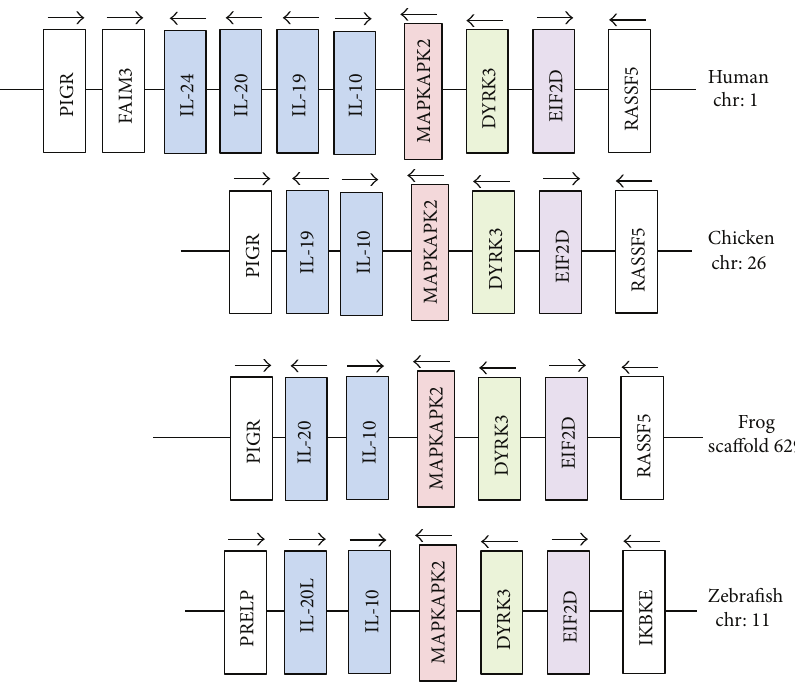
Figure 5: Gene synteny of IL-10 loci in vertebrates. The gene synteny of human, chicken, and zebrafish IL-10 locus was analyzed using Genomicus (v75.02) software and human IL-10 was set as a reference to compare the conserved synteny between different species. The gene synteny of frog IL-10 locus was based on the results of GenScan and BLAST search against NCBI